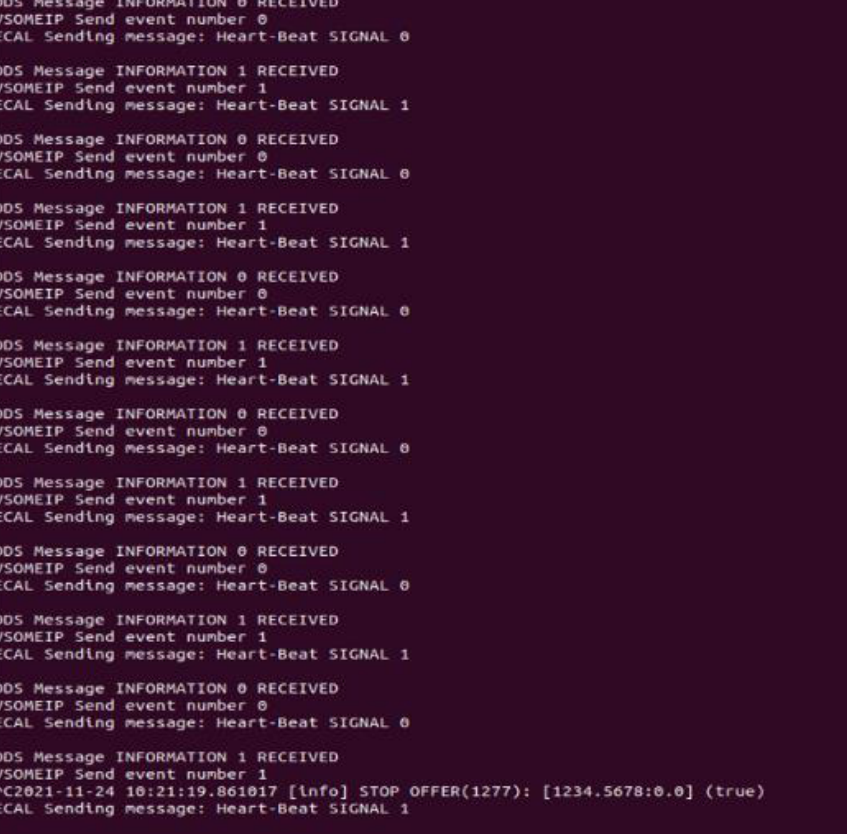
Figure 9. The interpreted pulse of the heartbeat event, according to receiving and transmitting sequences of the gateway application in case study 2.